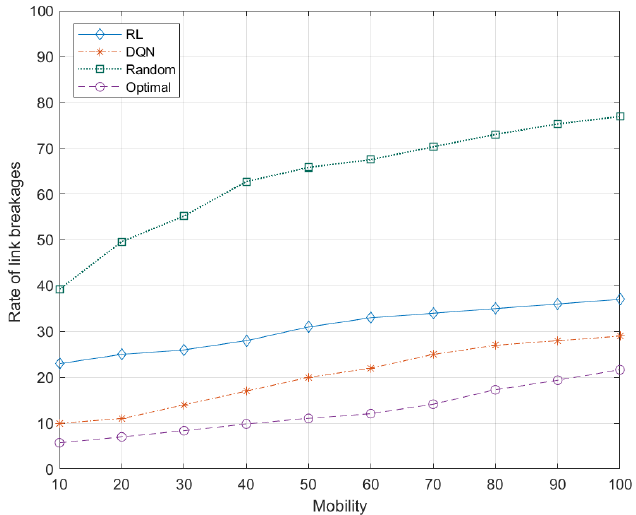
Figure 13. Rate of link breakages increases with respect to node mobility. DQN achieves lower values as compared to RL and random approaches. Lower rate of link breakages improves QoS and network